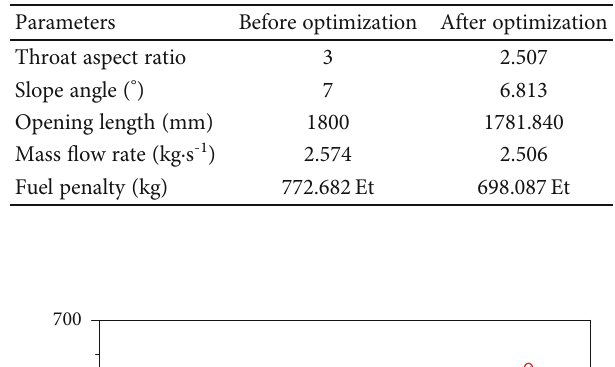
Table 5: Comparison of parameters before and after optimization.